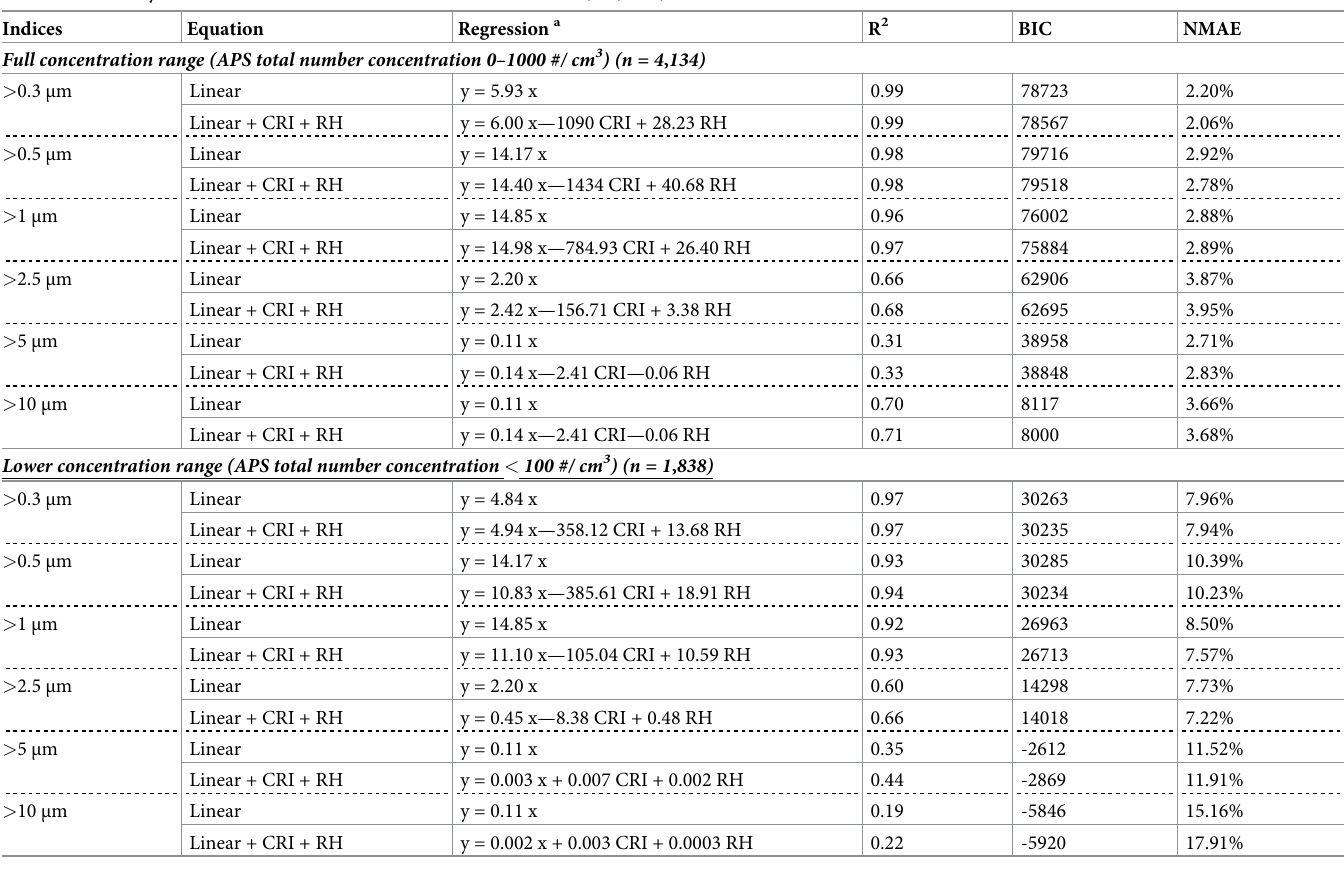
Table 3. Summary of the calibration models for number concentration, R 2 , BIC, and the NMAE of the calibration models. Indices